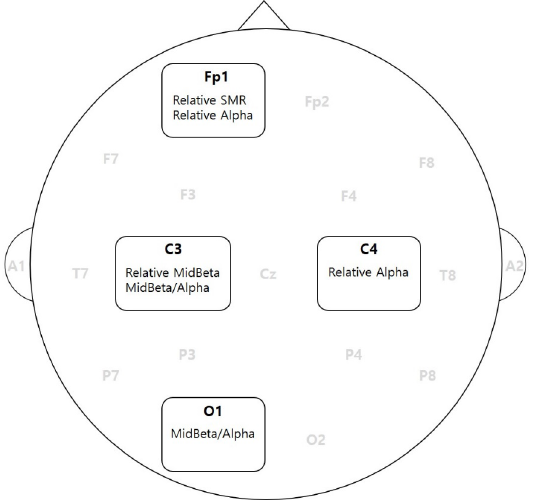
Figure 5. Location of EEG parameters significantly differentiating the IGD group.